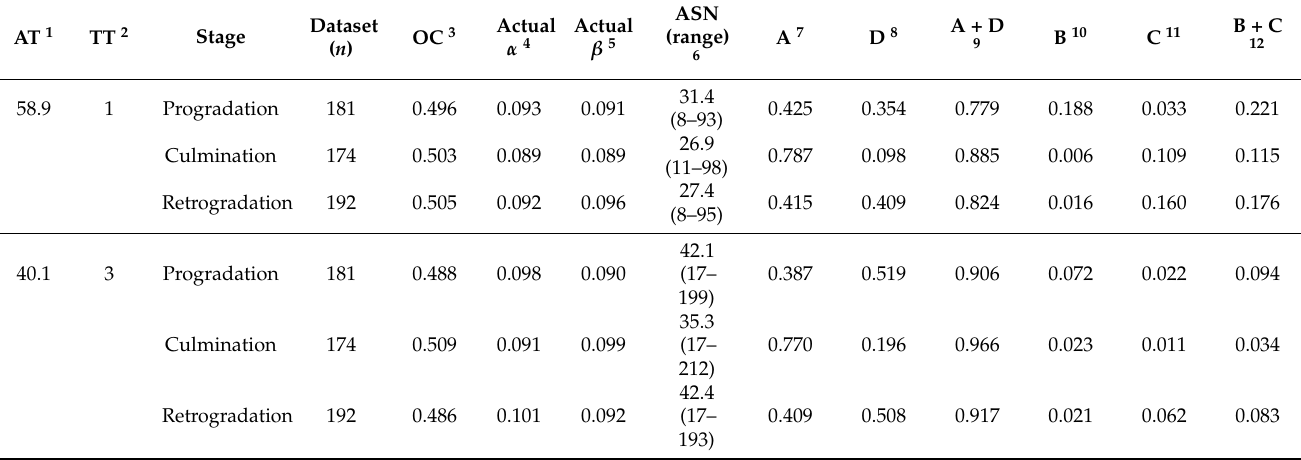
Table 4. Comparison of operation characteristics (OC value) and probabilities of correct (A and D) and incorrect (B and C) control decisions for sequential binomial sampling plans for cork oak trees occupied (AT = 58.5%) or infested (AT = 40.1%) by Lymantria dispar in progradation, culmination, and retrogradation